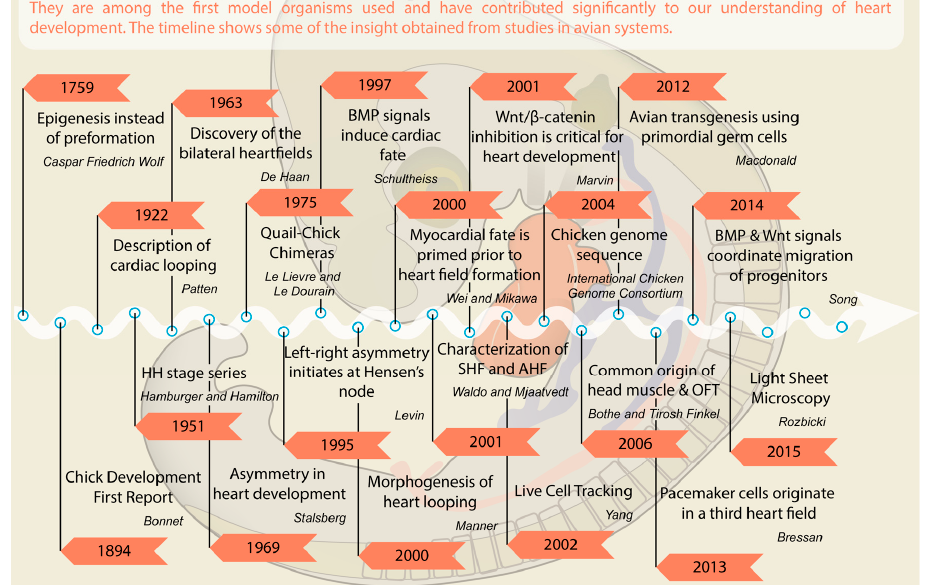
Figure 3. Timeline of important discoveries in chick embryos.